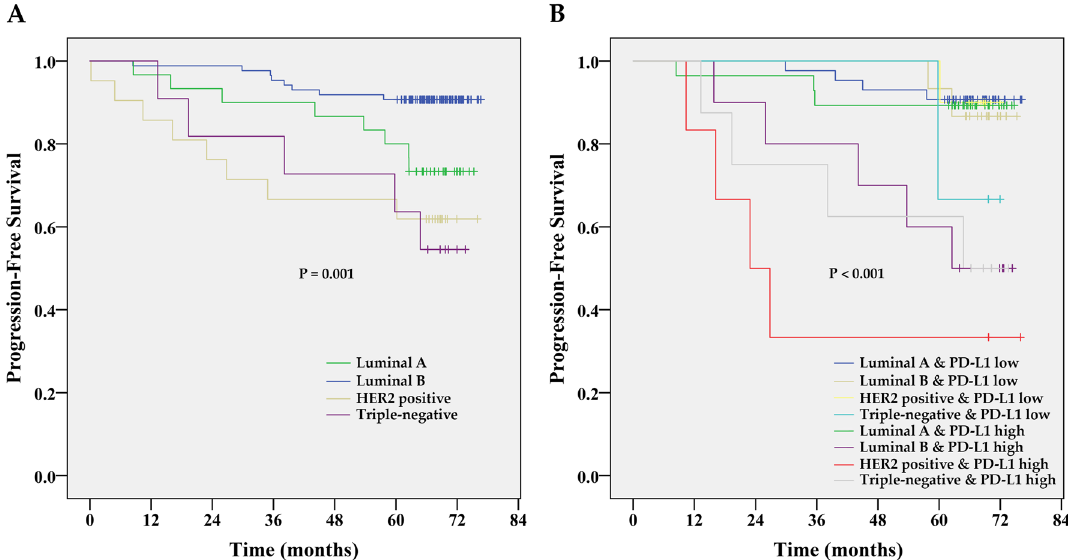
Figure 3. Kaplan–Meier PFS estimates for individual molecular subtypes ( A , P = 0.001 by log-rank test) and molecular subtype-stratified PD-L1 expression in the tumour ( B , P < 0.001 by log-rank